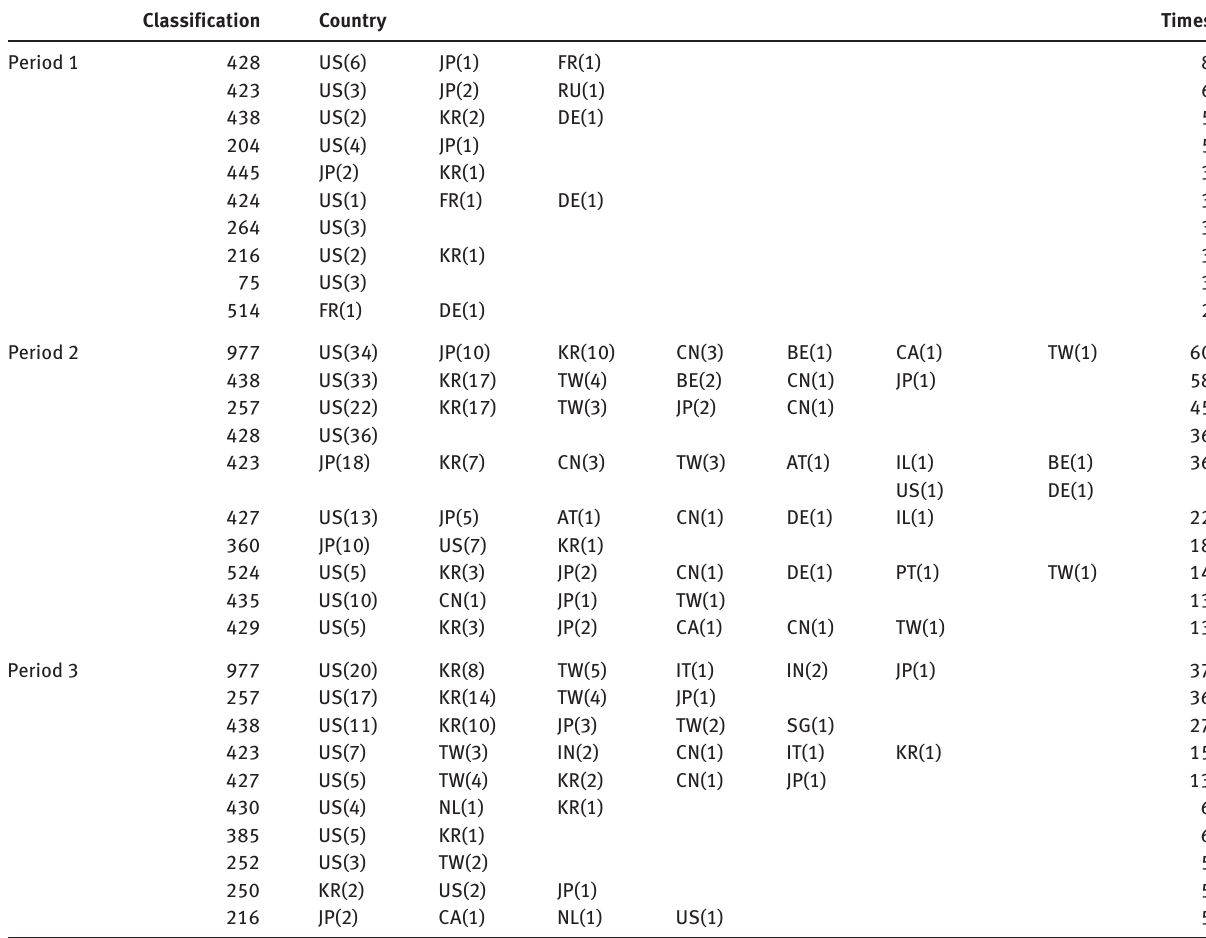
Table 2: The times of patent application for technological classifications in three periods. Classification Country